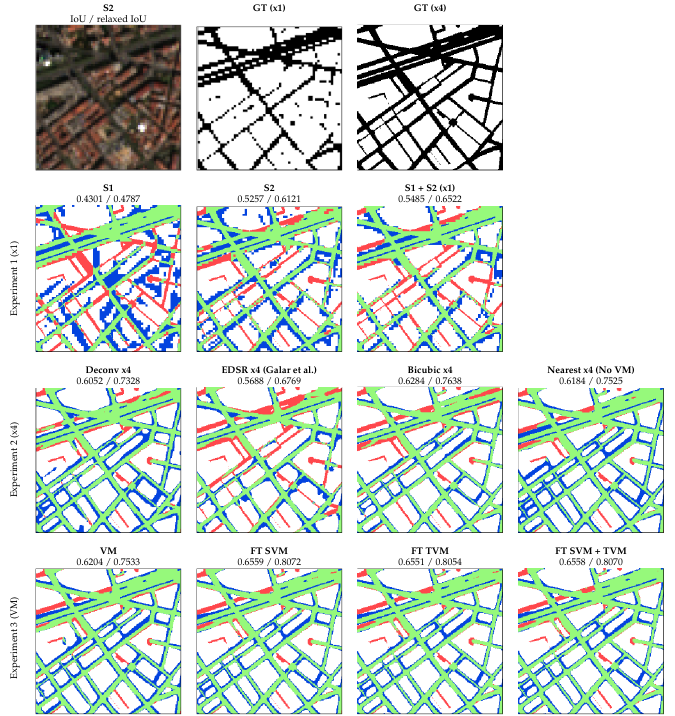
1 https://tracasa.es/sin-categoria-en/tracasa-succeeds-in-identifying-roads-and-highways-using-images-from-sentinel-satellites-super-resolved- with-artificial-intelligence/